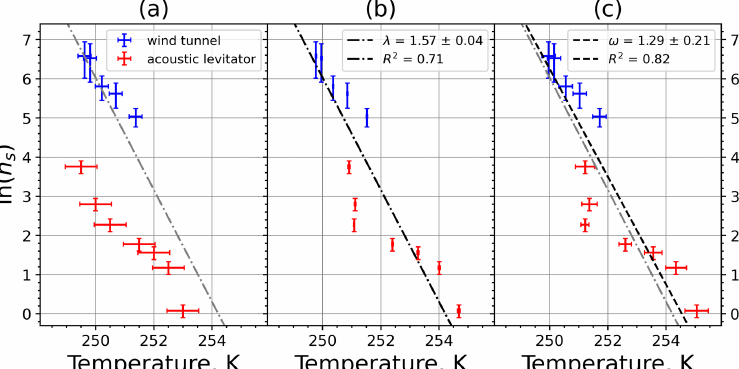
Figure A4. (a) Composite INAS density spectrum of MCC from the uncorrected M-WT (blue) and M-AL (red) measurements. Panels (b) and (c) show the temperature-corrected data points from the M-WT and M-AL experiments based on λ and ω , respectively. The dash-dotted line in (c) is the regression line on corrected data points obtained by employing the optimal λ value as in (b)